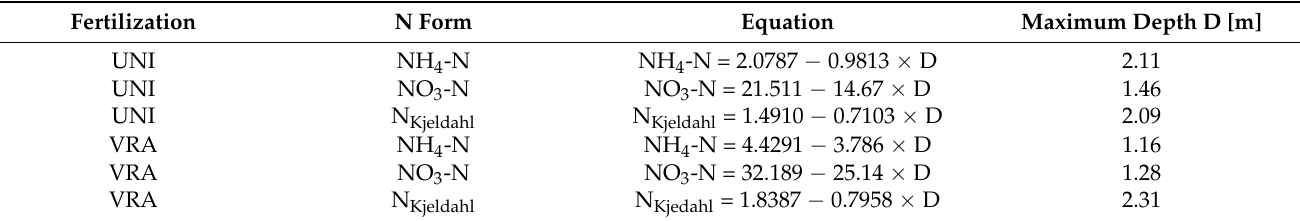
Table 5. Concentration of N form as a function of soil depth.